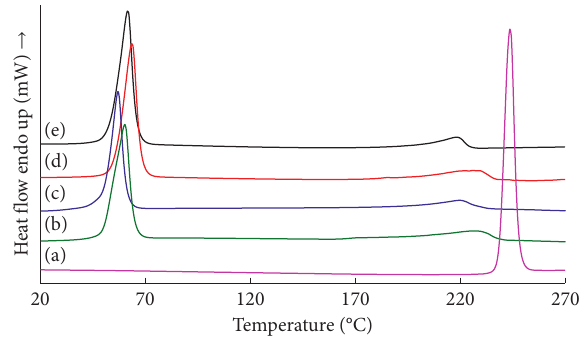
Figure 4: DSC thermograms of (a) pure AG, (b) AG-PEG4000 palmitate-PM, (c) AG-PEG4000 palmitate-SD, (d) AG-PEG8000 palmitate-PM, and (e) AG-PEG8000